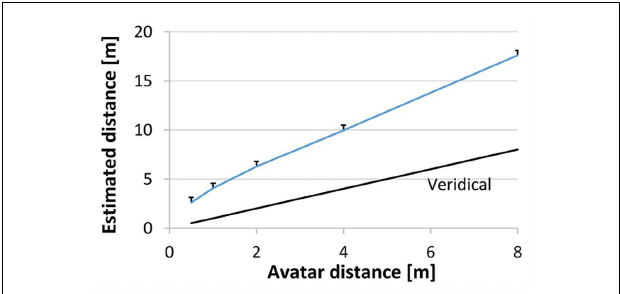
FIGURE 3 | Estimated distance of the participants as a function of distance. Means and standard errors as estimated from the marginal means are shown.